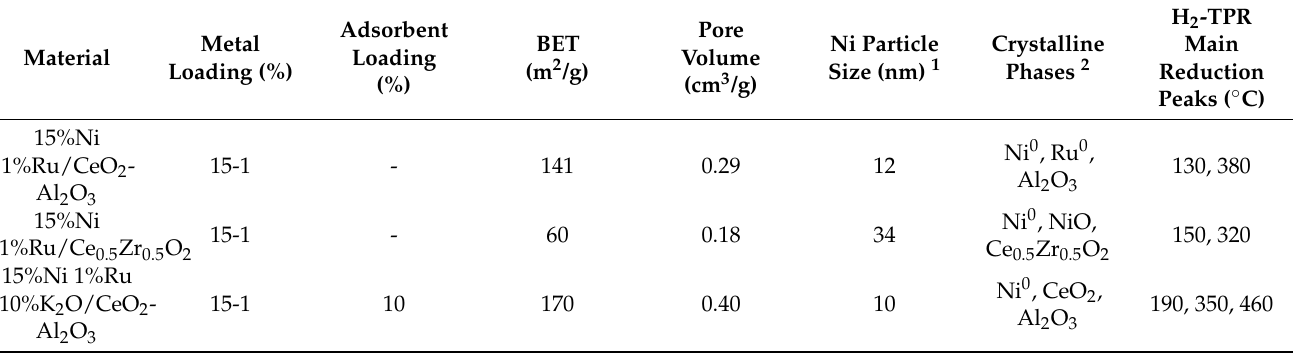
Table 2. Summary of characterisation data of NiRu/CeAl, NiRu/CeZr [26], and NiRuK/CeAl [51].